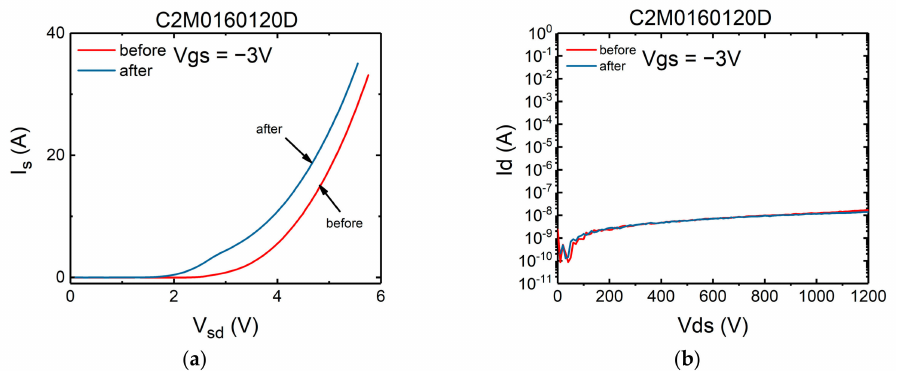
Figure 7. The characteristics of SiC MOSFET’s body diode (C2M1060120D) before and after the failure ( a ) forward conduction characteristics, ( b ) reverse blocking